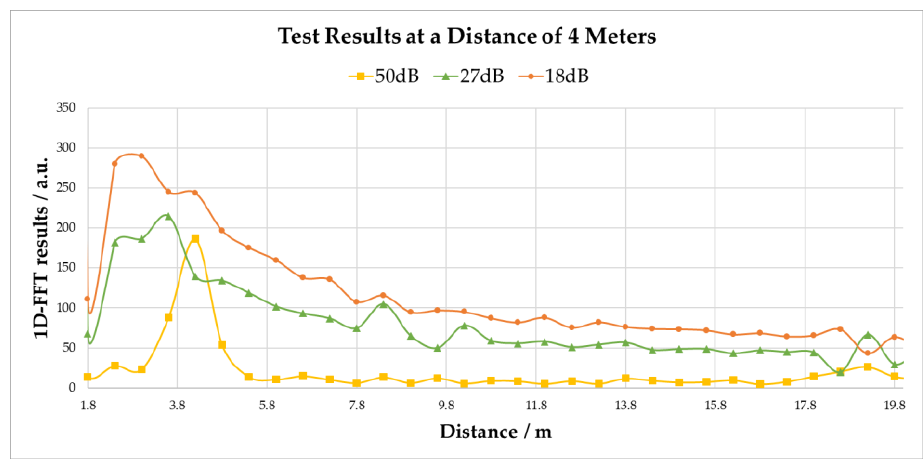
Figure 7. 1D-FFT test results of the target distance of 4 m from the radar.